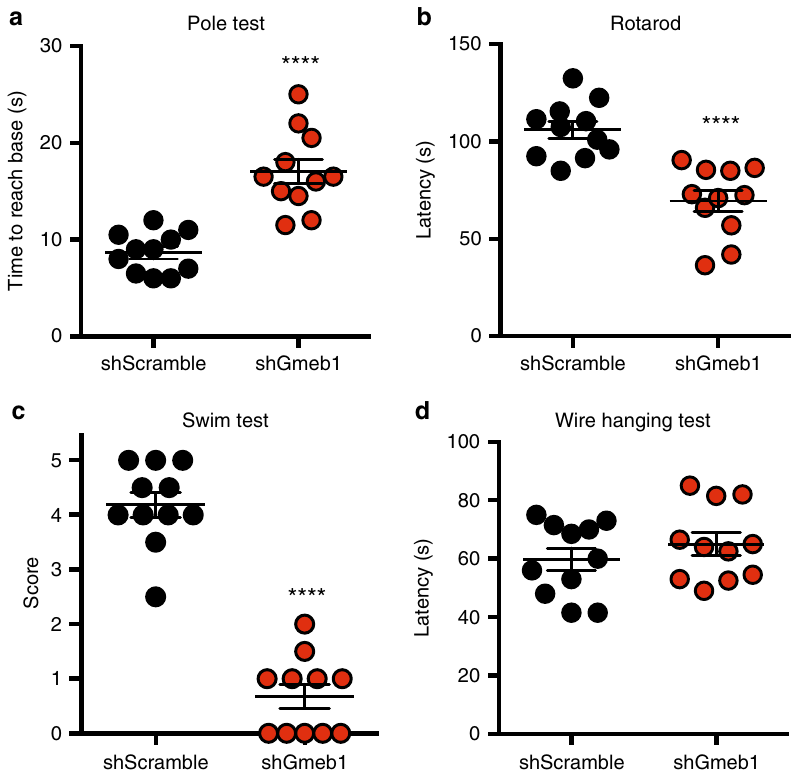
Fig. 5 Midbrain Gmeb1 knockdown results in motor impairments. a Dot plot representing mean (±s.e.m.) time (s) required for mice with midbrain knockdown of Gmeb1 or shScramble control mice to reach bottom of pole ( n = 11 per group, **** p < 0.0001 in two-tailed t -test). b Dot plot representing mean (±s.e.m.) latency (s) at which mice with midbrain knockdown of Gmeb1 or shScramble control mice fall from rotarod or cling to apparatus without active locomotion ( n = 11 per group, **** p < 0.0001 in two-tailed t -test). c Dot plot representing mean (±s.e.m.) score re fl ecting the ability of Gmeb1 or shScramble to swim over a 5-min period ( n = 11 per group, **** p < 0.0001 in two-tailed t -test). d Dot plot representing mean (±s.e.m.) latency (s) at